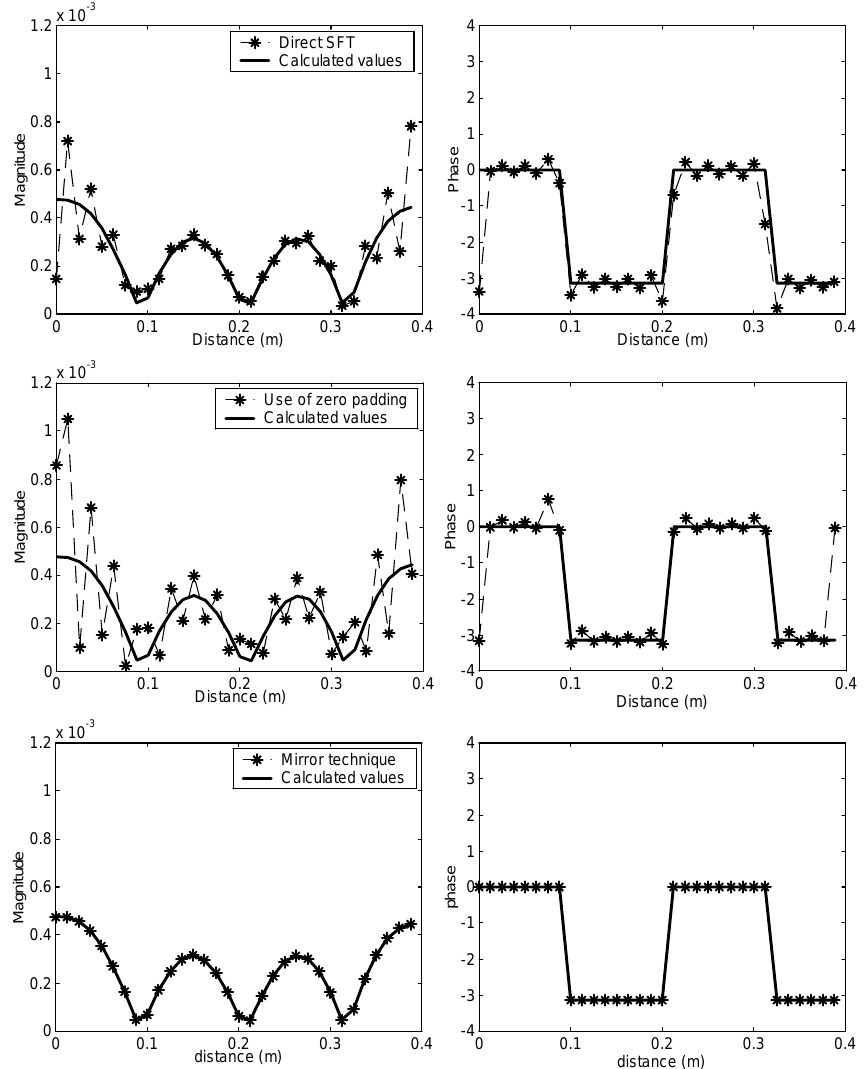
Fig. 5. Magnitude (left) and phase (right) of the derivative of the displacement dv/dx of a beam with free-free boundary conditions excited by a point force at f = 500 Hz obtained by processing in wavenumber domain: use of direct SFT (top), use of zero-padding (middle), use of mirror method (bottom). The exact values of dv/dx are represented by the solid